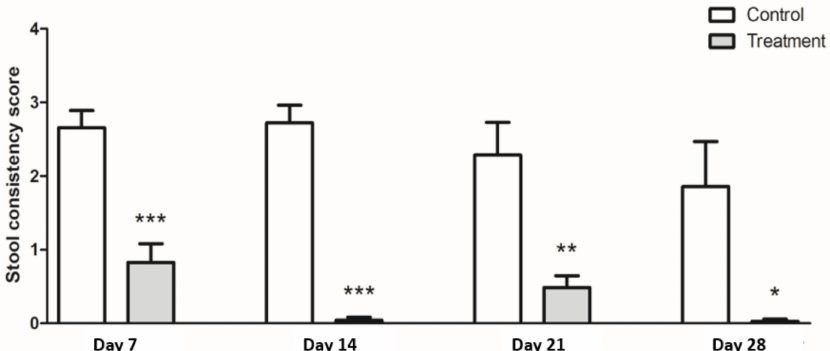
Figure 3. Stool consistency scores. Treatment group (gray bar) showed lower stool consistency score than the control group (white bar). Results are expressed as the mean ± SEM ( n = 7/group). * Indicates significant p-value differences by an unpaired t -test; * p < 0.05, ** p < 0.01, *** p <